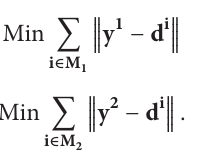
Algorithm 1. A new algorithm for classification problem